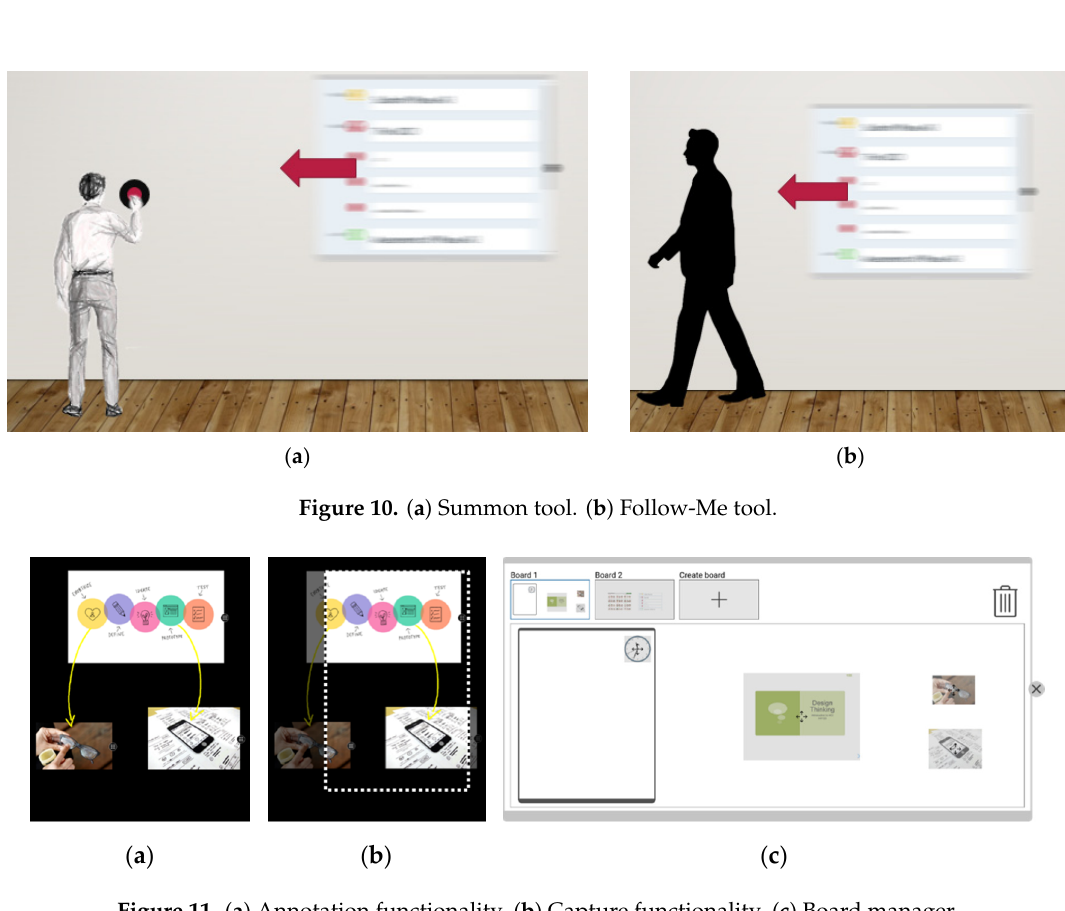
Figure 11. ( a ) Annotation functionality. ( b ) Capture functionality. ( c ) Board manager.